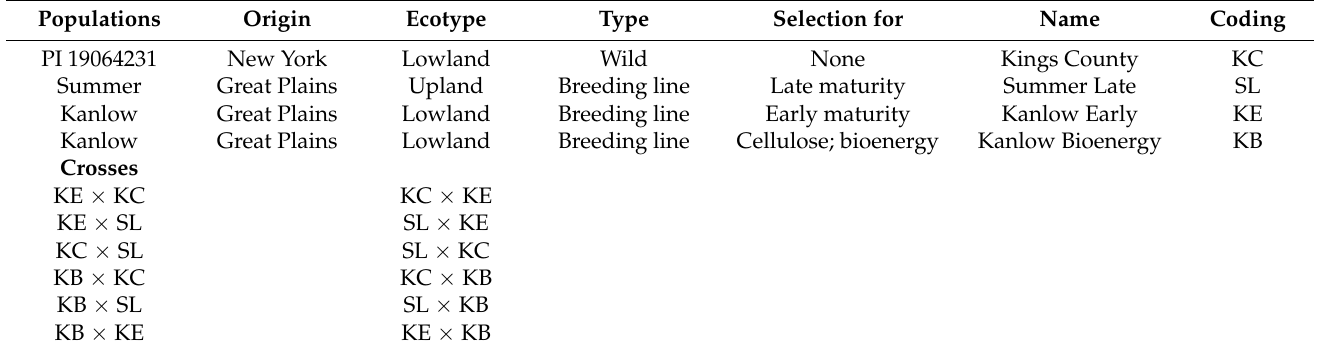
Table 1. Description of the switchgrass parental and reference populations and number of crosses. Populations Origin